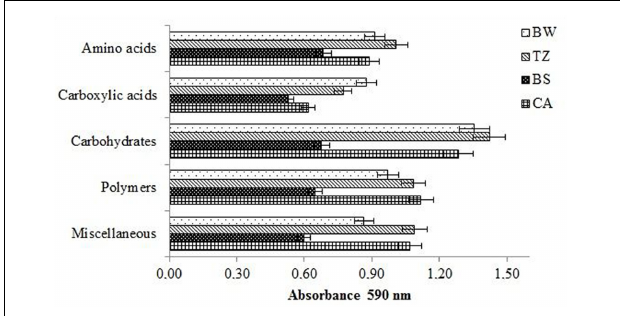
FIGURE 5 | Categorized substrates utilization pattern by microbial communities. Errors bars represent the standard error of the mean ( n = 3).